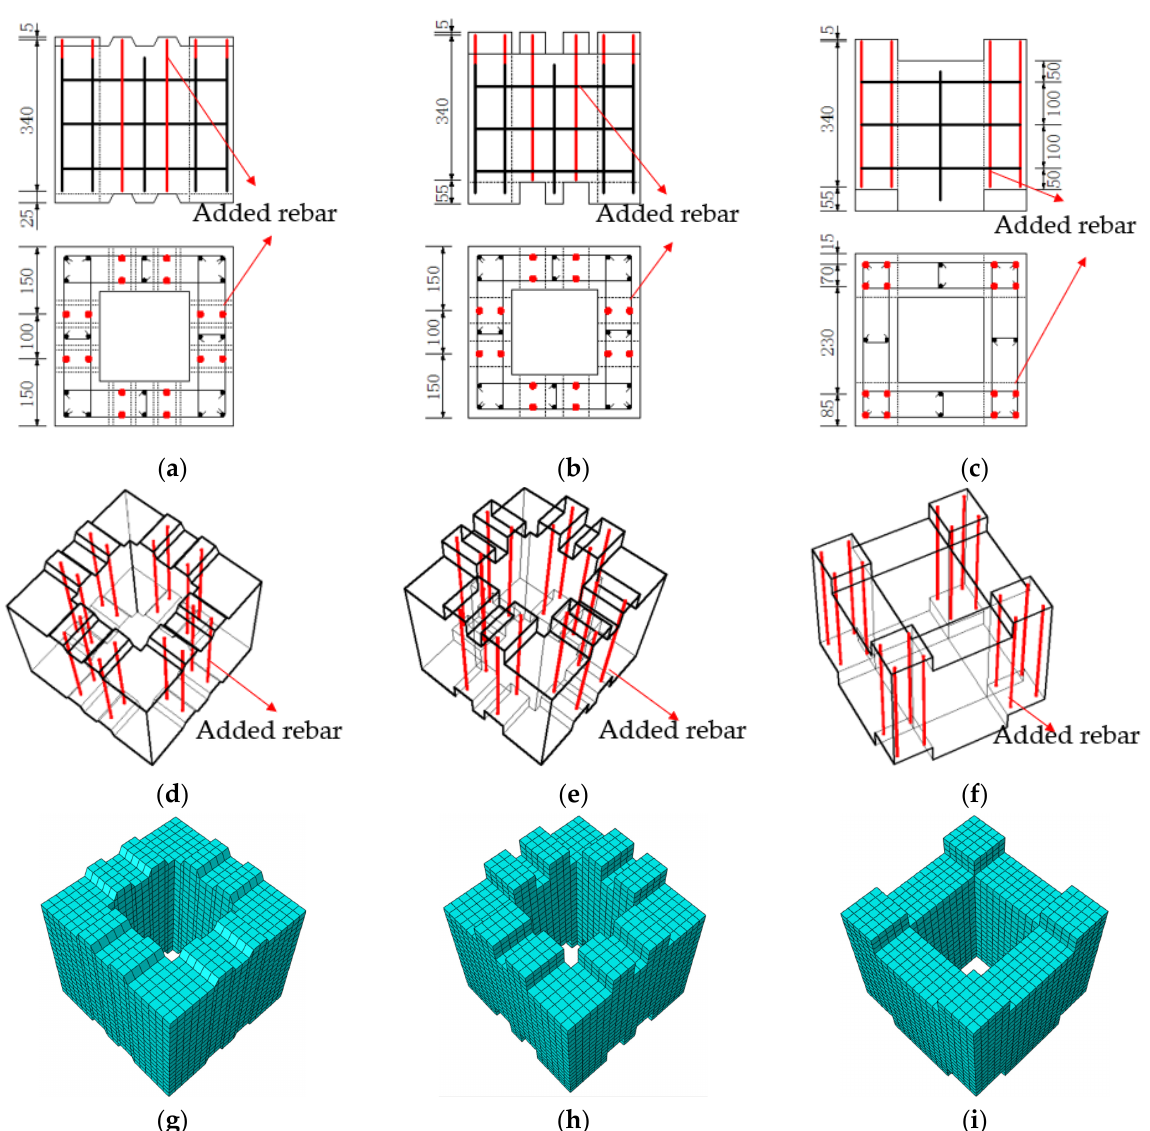
Figure 14. Optimized design solution. ( a ) Detail of plan A. ( b ) Detail of plan B. ( c ) Detail of plan C. ( d ) Segment overview of plan A. ( e ) Segment overview of plan B. ( f ) Segment overview of plan C. ( g ) Segment FEM of plan A. ( h ) Segment FEM of plan B. ( i ) Segment FEM of plan C.